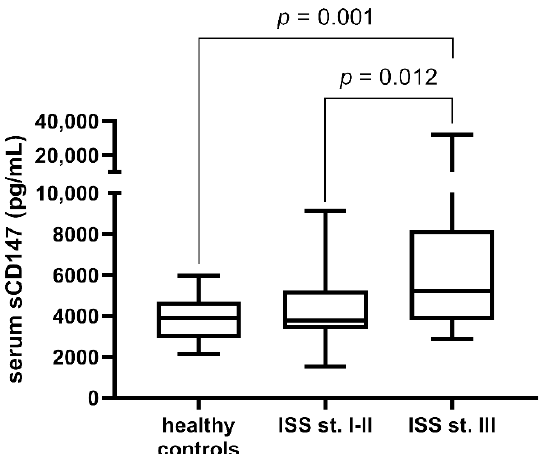
Figure 2. Serum sCD147 in patients in stages I-II and in patients in stage III of the International Staging System, or ISS. Healthy controls are also included. Patients in the more advanced stage III are characterized by higher sCD147 levels than both patients in the stages I-II ( p = 0.014), and healthy controls ( p = 0.002). Concurrently, healthy individuals did not significantly differ from patients in stages I-II ( p = 0.279).